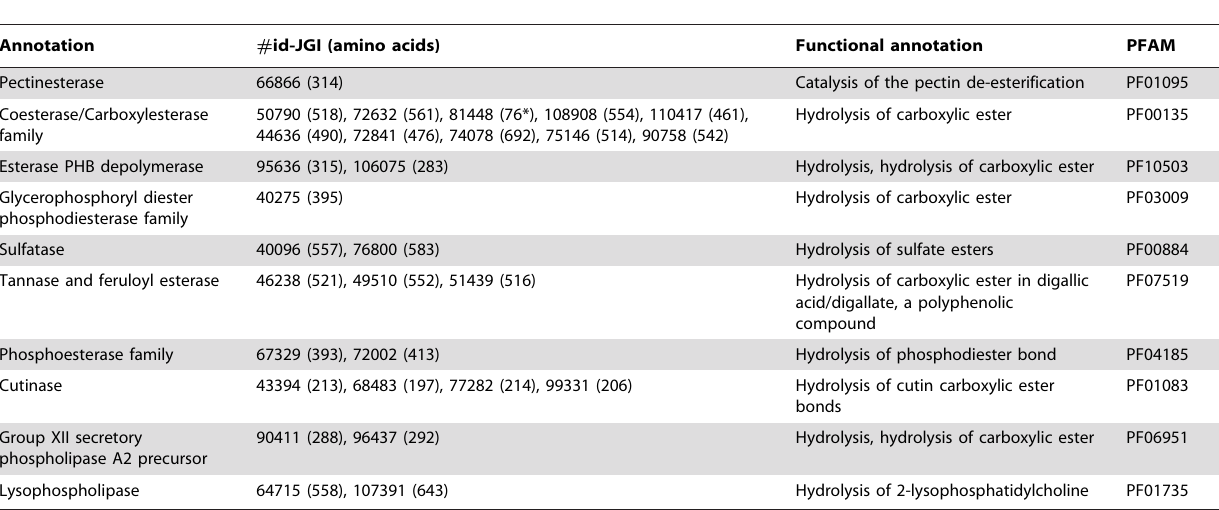
Table 4. The sub-set of M. graminicola genes that code for secreted proteins involved in the lipids degradation.